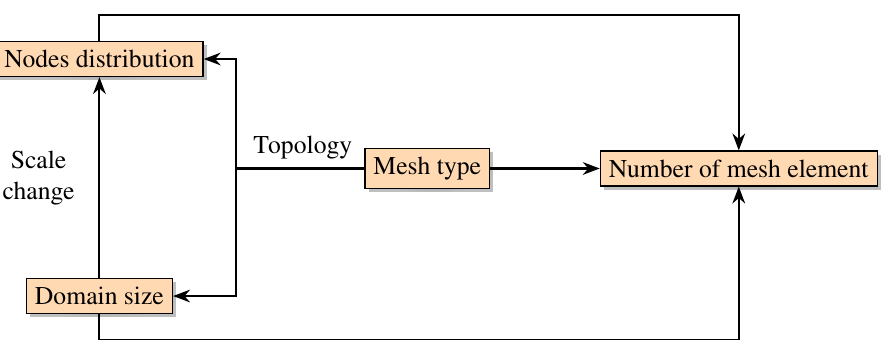
Figure 5. Relationship between different mesh